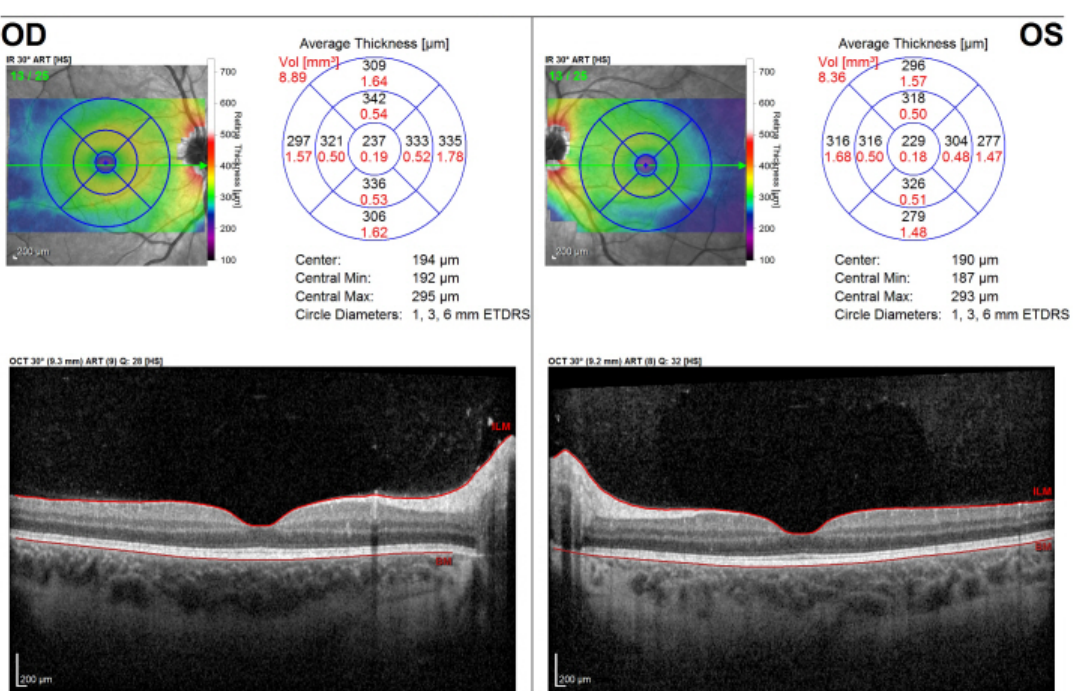
Figure 1: Initial presentation. Optical coherence tomography (OCT) of the right (OD) and left (OS) macula, demonstrating a normal retinal architecture of the macula and fovea in both